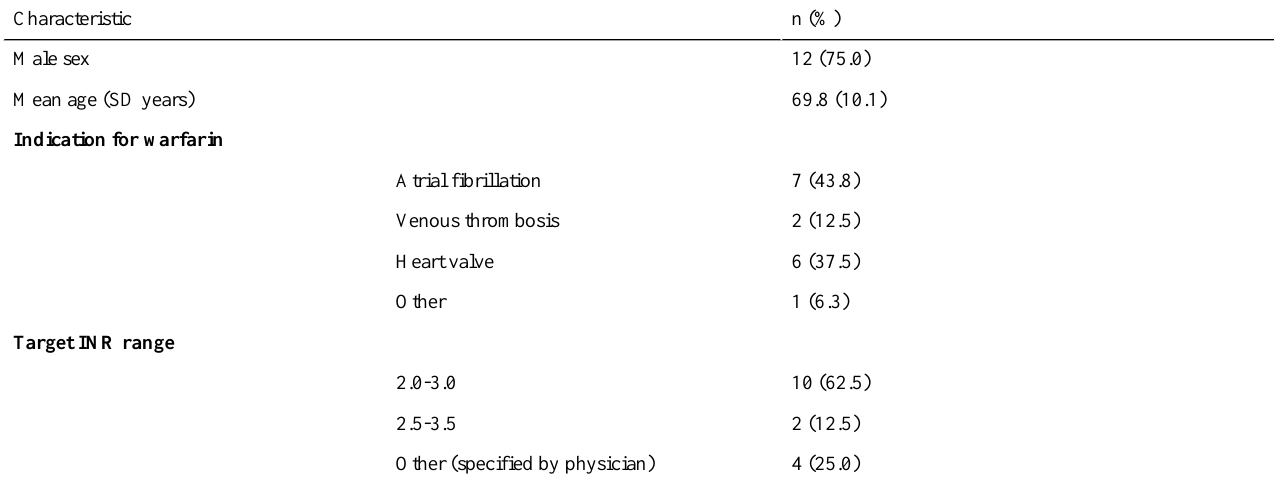
Table 1. Patient